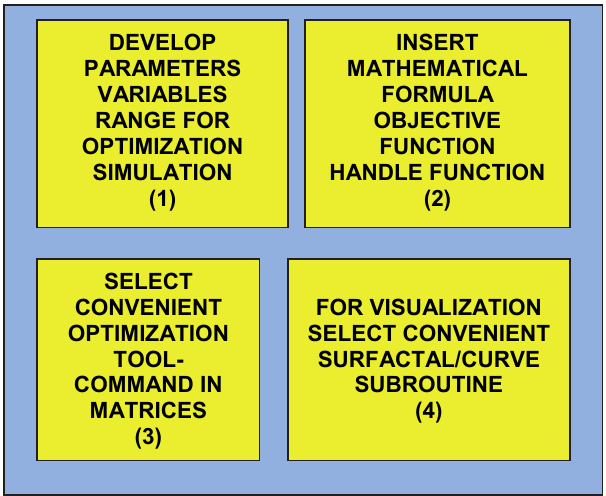
Fig. 6. 3D surfactal simulation results for Table III and Eq. (2) model. The impact velocity is 40 m/s. Results are acceptable with a Global Minimum sharply determined by cursor that verifies the optimization software results. Matrices of imaging are 75 ×